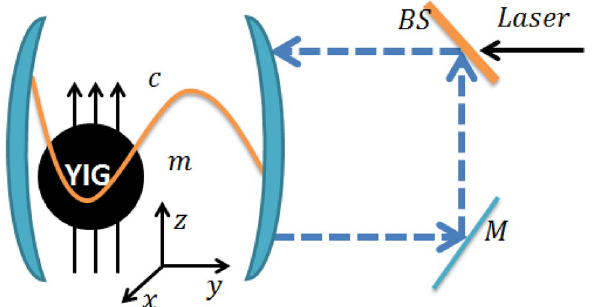
Figure 1. Schematic diagram of a single-mode cavity with feedback loop and a YIG sphere. The cavity is also driven by an electromagnetic field with amplitude (cid:31) , an input light field enters in the cavity across an asymmetric beam splitter (BS). The output field is totally reflected on the mirror M and a part of the output field is sent to the cavity via beam splitter. The magnons are embodied by a collective motion of a large number of spins in a macroscopic ferrimagnet, and the magnon mode is directly driven by a microwave source (not shown) to enhance the magnomechanical coupling. The cavity photons and magnons are coupled via magnetic dipole interaction, and the magnons and phonons are coupled via magnetostrictive (radiation pressure-like)